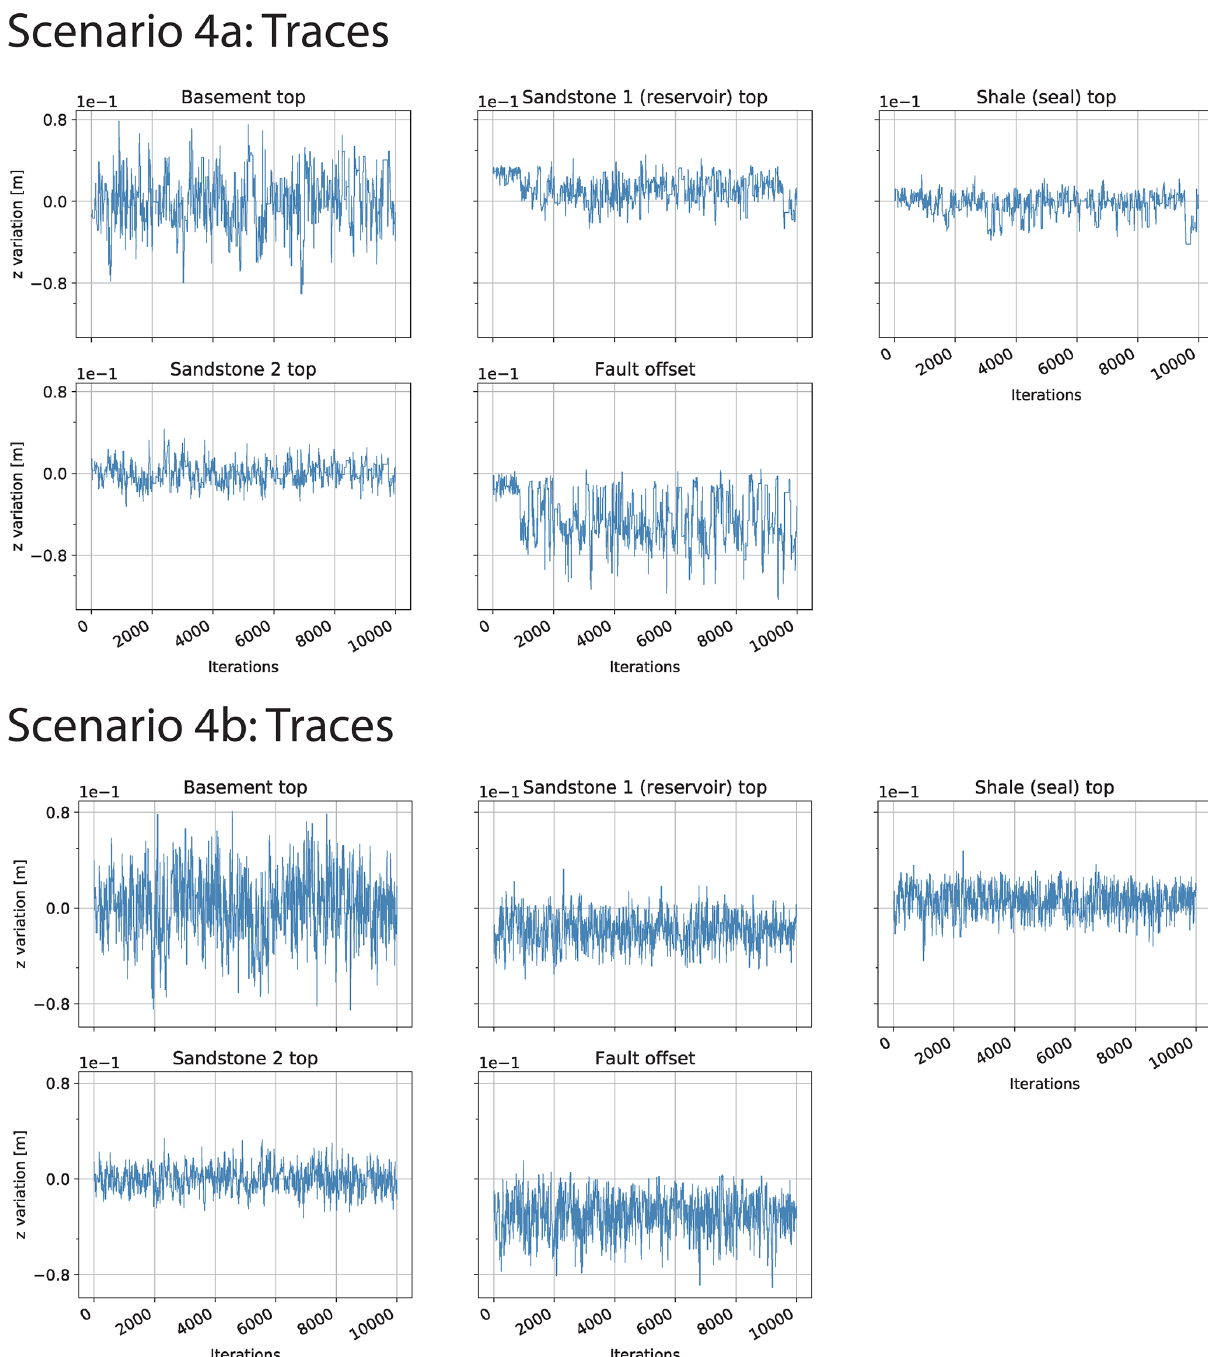
Figure C2. Geweke plots and traces for Scenarios 4a and